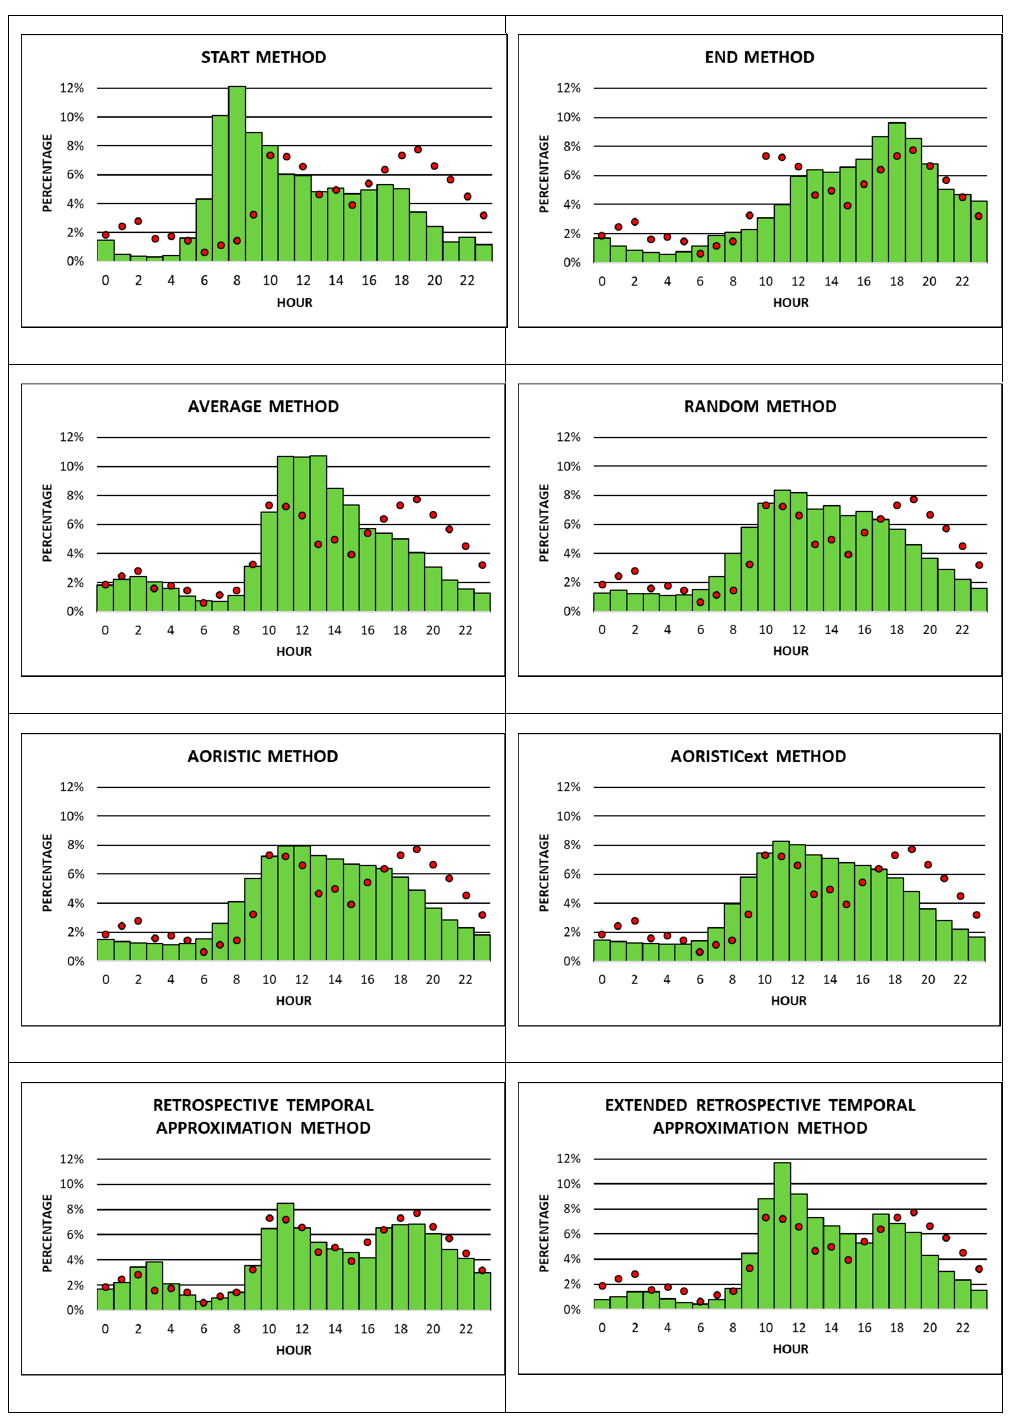
Figure 4. Comparing observed (red dots) and estimated (green bars) occurrence times of apartment burglaries in Vienna, Austria between